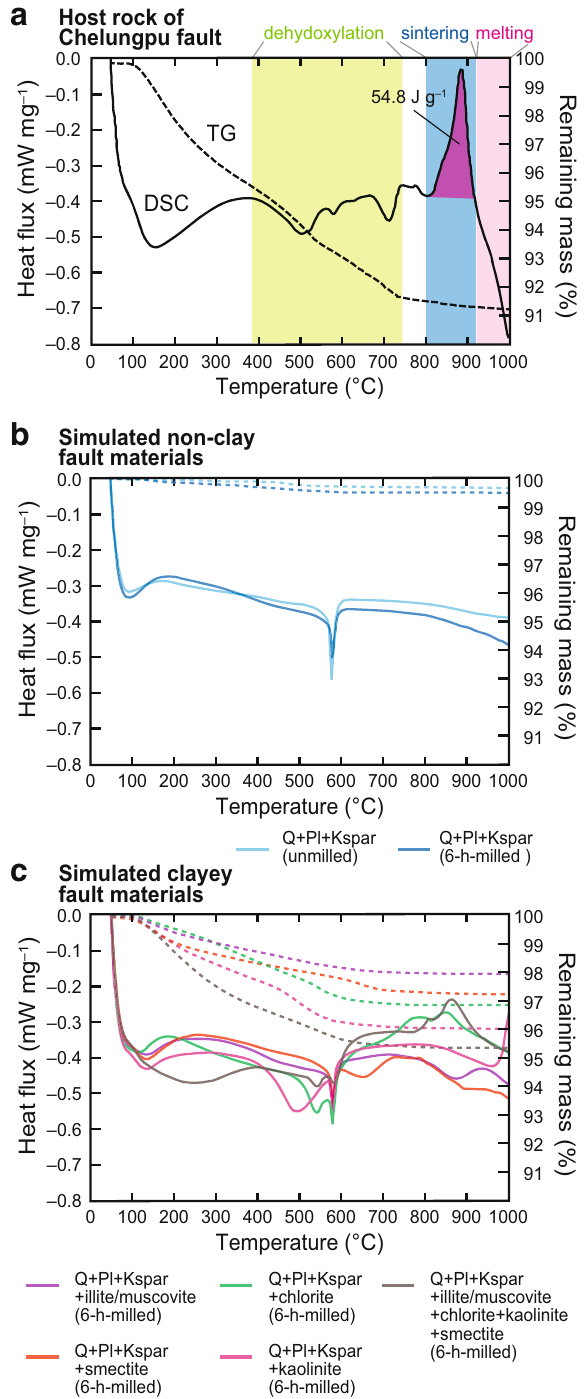
Fig. 3 Simultaneous thermogravimetry (TG) — differential scanning calorimetry (DSC) results. TG – DSC pro fi les of a a host-rock sample collected near the Chelungpu fault, b simulated non-clay fault materials composed of quartz, plagioclase and K-feldspar, and c simulated clayey fault materials composed of non-clay minerals (quartz, plagioclase, and K- feldspar) and one or all of illite/muscovite, chlorite, kaolinite, and smectite. Dotted and solid curves show the TG and DSC data, respectively. Q quartz, Pl plagioclase, Kspar